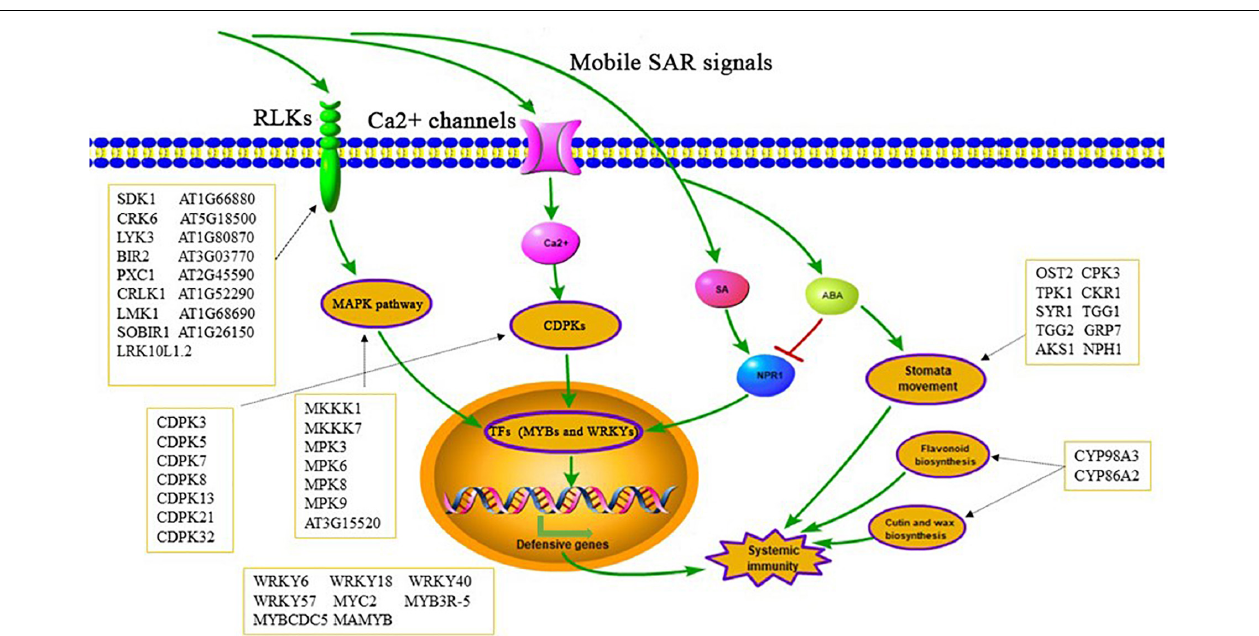
FIGURE 10 | Possible pathways of significantly changed phosphoproteins involved in SAR